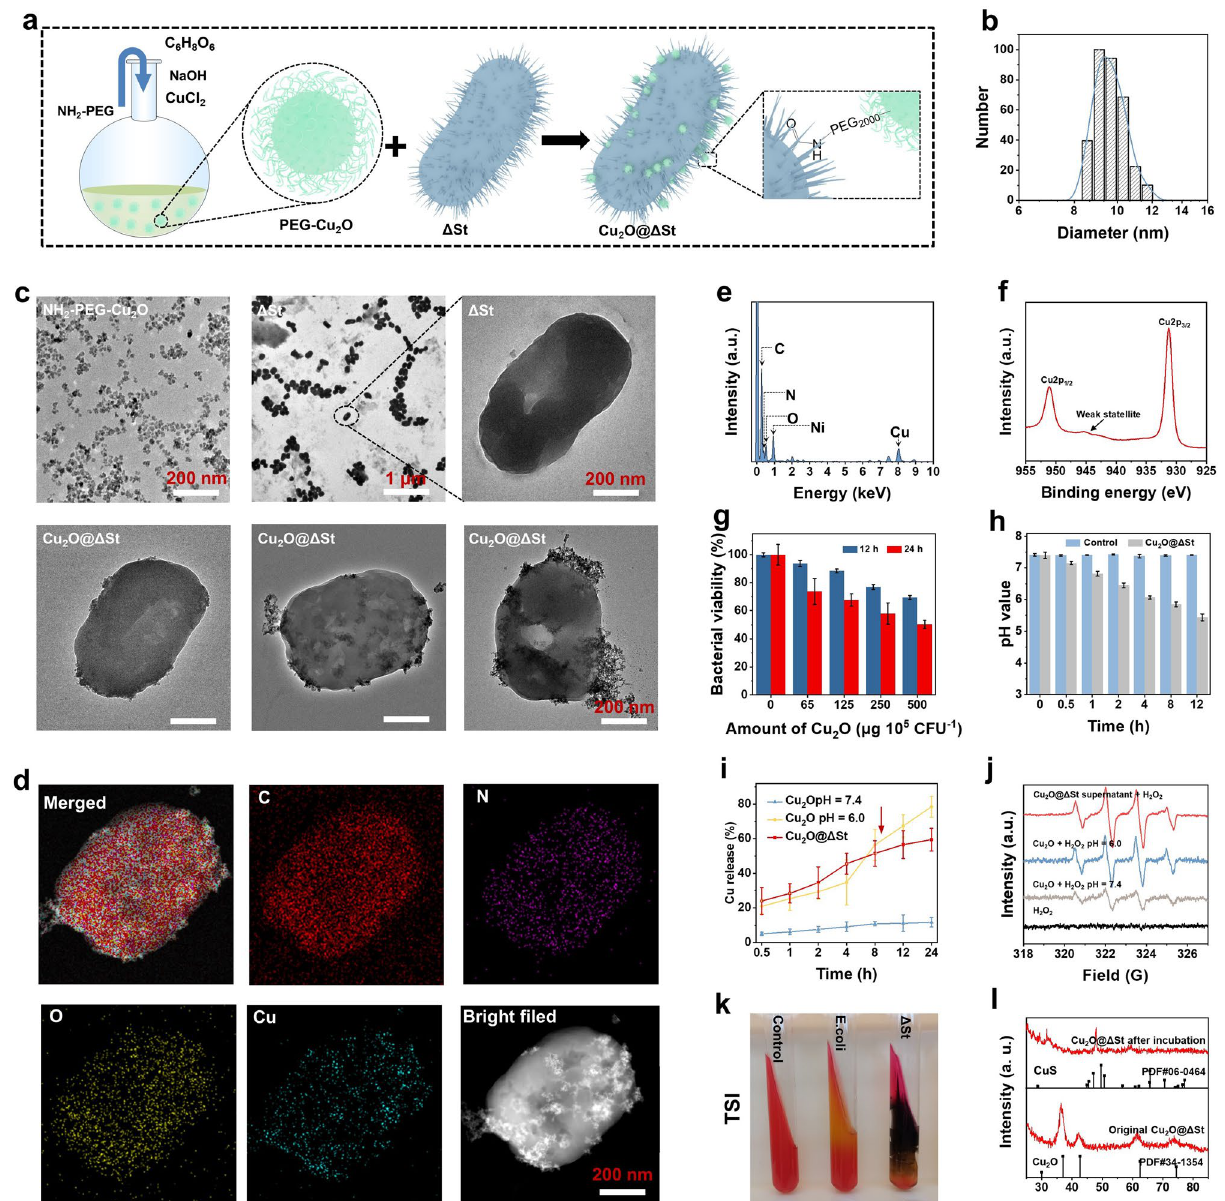
Fig. 1 Fabrication and characterization of Cu 2 O@ΔSt. a Schematic illustration of the synthesis of Cu 2 O and the linkage of Cu 2 O onto ΔSt. b The hydrodynamic diameter of Cu 2 O determined by dynamic light scattering (DLS) detection. c TEM images of Cu 2 O, ΔSt, and Cu 2 O@ΔSt at the feed ratios of 65, 125, and 250 μg Cu 2 O per 10 5 CFU ΔSt. d Elemental mappings of Cu 2 O@ΔSt. e EDS of Cu 2 O@ΔSt. f XPS spectra of Cu 2 O. g Bacterial viabilities of ΔSt treated with different feed doses of Cu 2 O for 12 and 24 h ( n = 6, mean ± standard error). h The pH values at different time points of the medium with or without the addition of Cu 2 O@ΔSt ( n = 3, mean ± standard error). i Accumulated Cu release from Cu 2 O@ΔSt after incubation for varied time durations ( n = 3, mean ± standard error). j ESR spectra of different reaction systems. k Color changes of triple sugar iron agar media after planting with different bacteria. l XRD patterns of original Cu 2 O@ΔSt powder and that